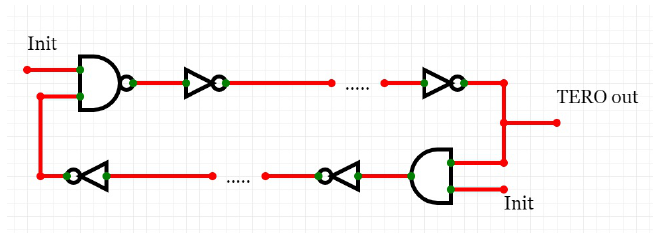
Figure 8. TERO PUF architectures. Adapted from